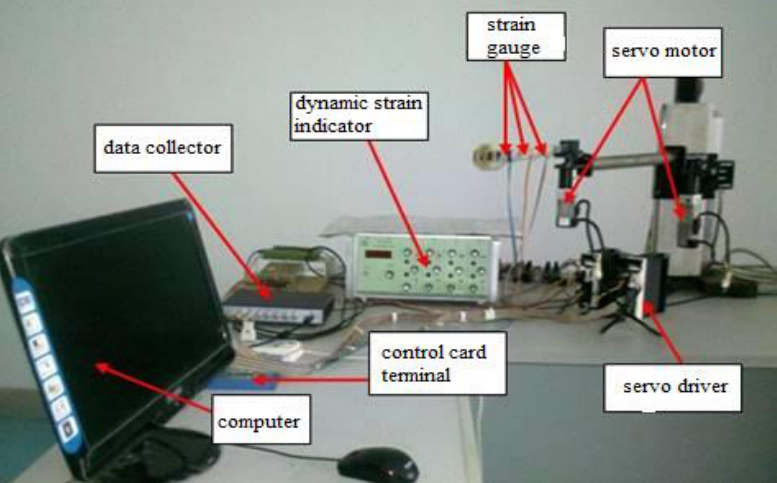
Table 3. Parameter table of AC servo motor.